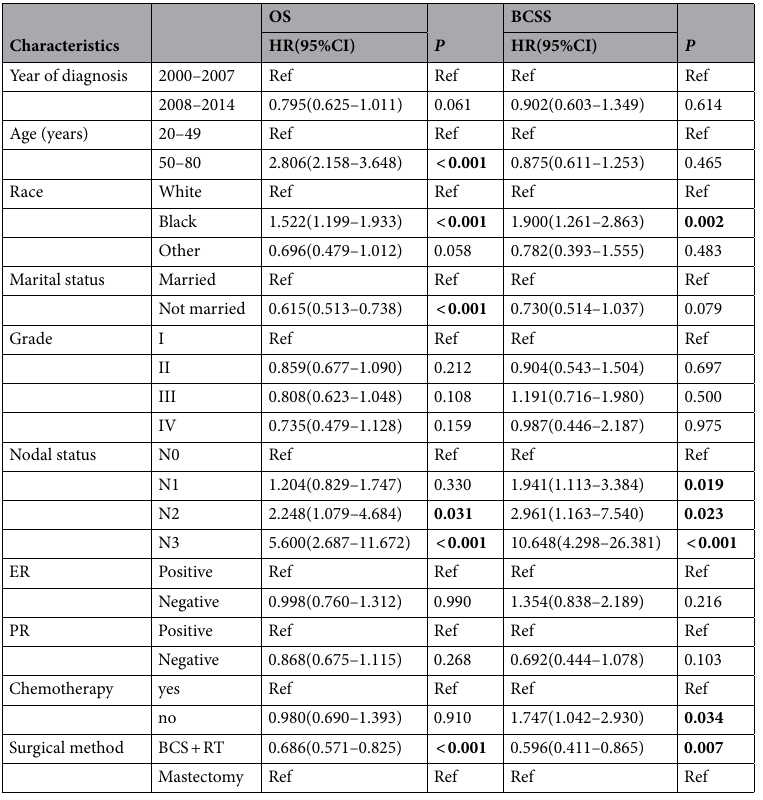
Table 2. Prognostic factors for OS and BCSS in multivariate analysis OS overall survival; BCSS breast cancer- specific survival. Significant values are in